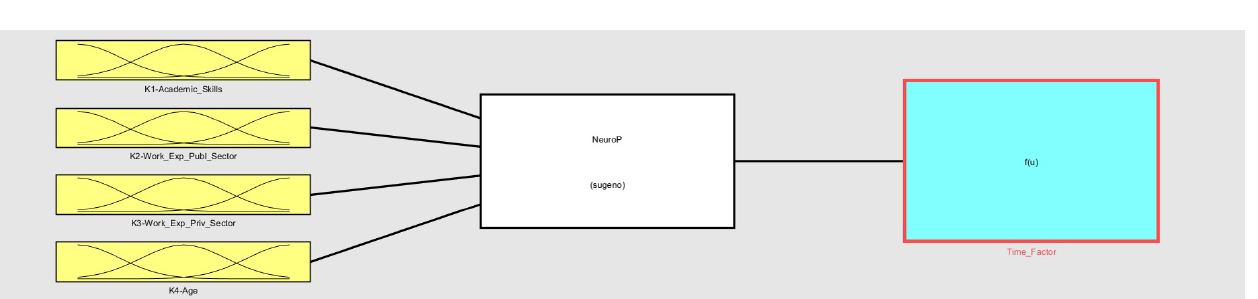
Figure 5. Overview of the fuzzy system